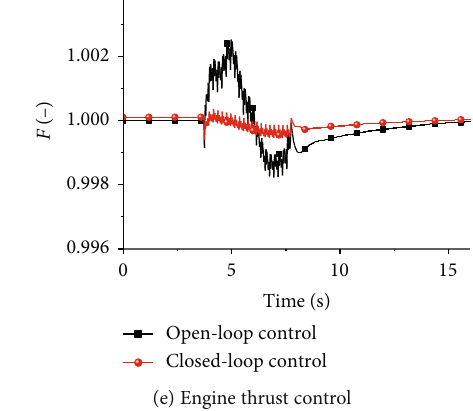
Figure 13: Simulation results of an integrated model under Mach number